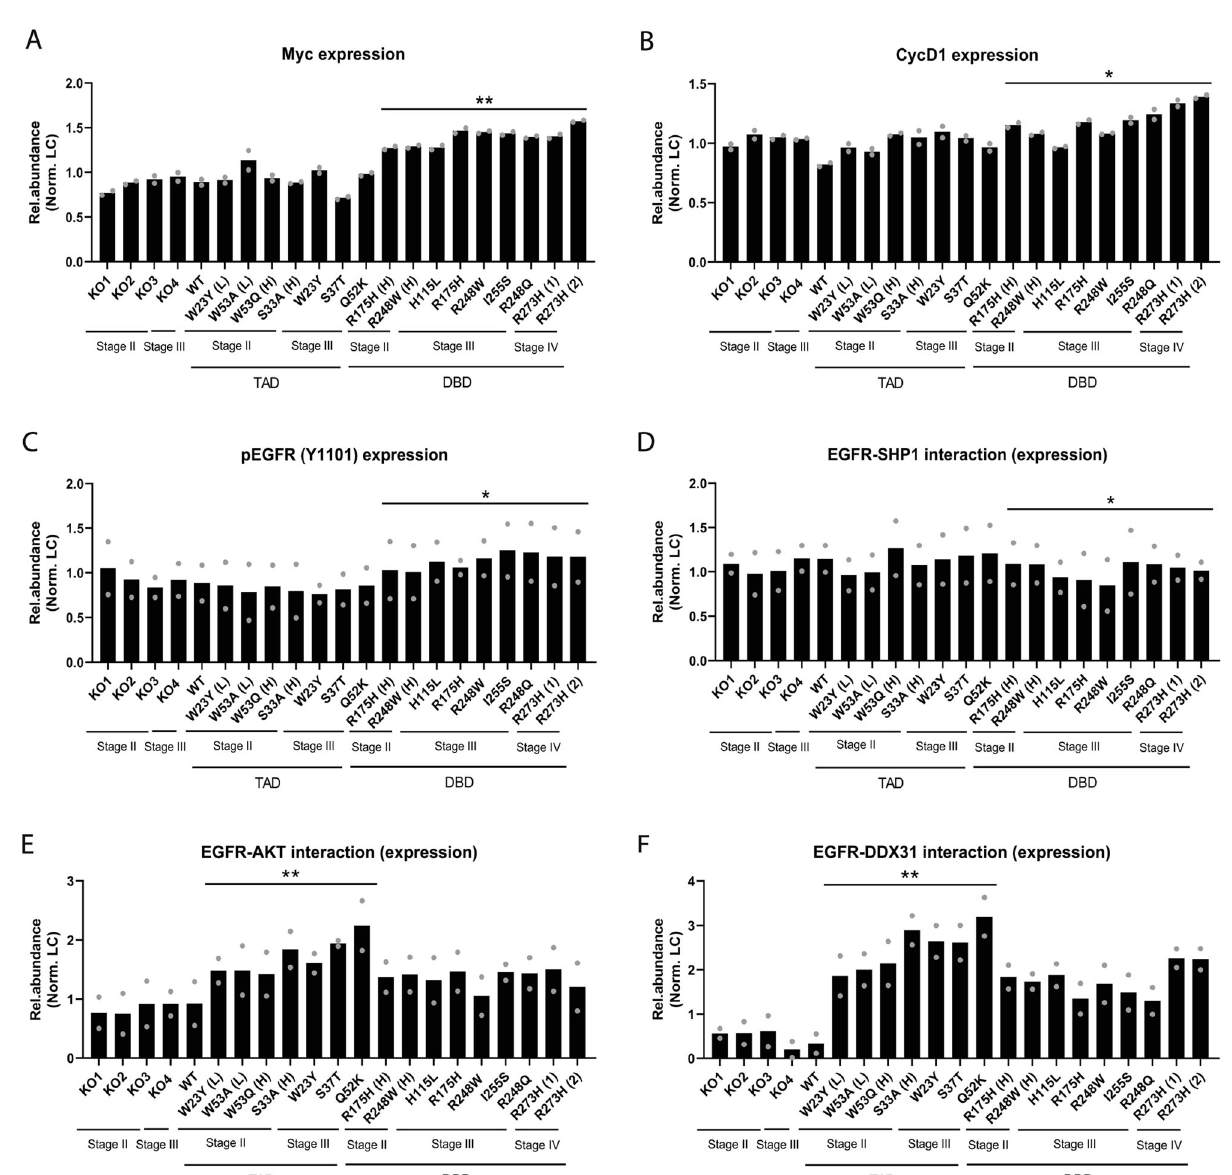
Fig. 4 | p53 TAD and DBD mutant CRC tumors recapitulate differential EGFR- dependent changes. A – C Quanti fi cation of A c-Myc, B Cyclin D1, and C nuclear pEGFR(Y1101)proteinlevelsinp53nullandTADandDBDmutantpatientcolorectal tumors. D – F Quanti fi cation of D nuclear SHP1 (after EGFR pulldown), E cytosolic AKT (after EGFR pulldown), and F cytosolic DDX31 (after EGFR pulldown) protein